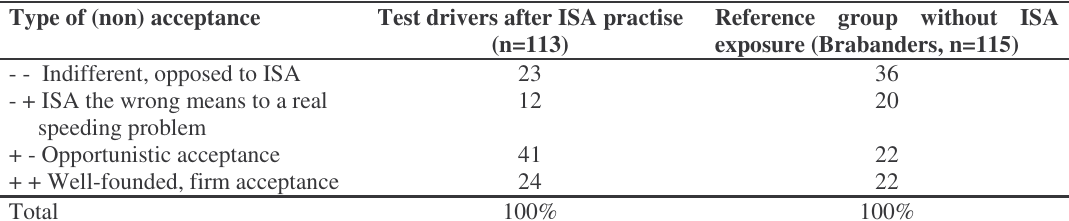
Table 5. Depth of the ISA